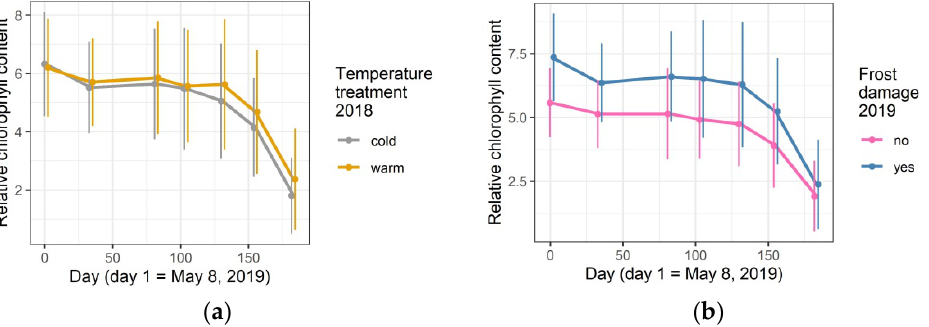
Figure 8. Mean and standard deviation for relative leaf chlorophyll content of the seedlings in 2019, according to the temperature treatment in 2018 ( a ) and the late spring frost in the spring of 2019 ( b ).